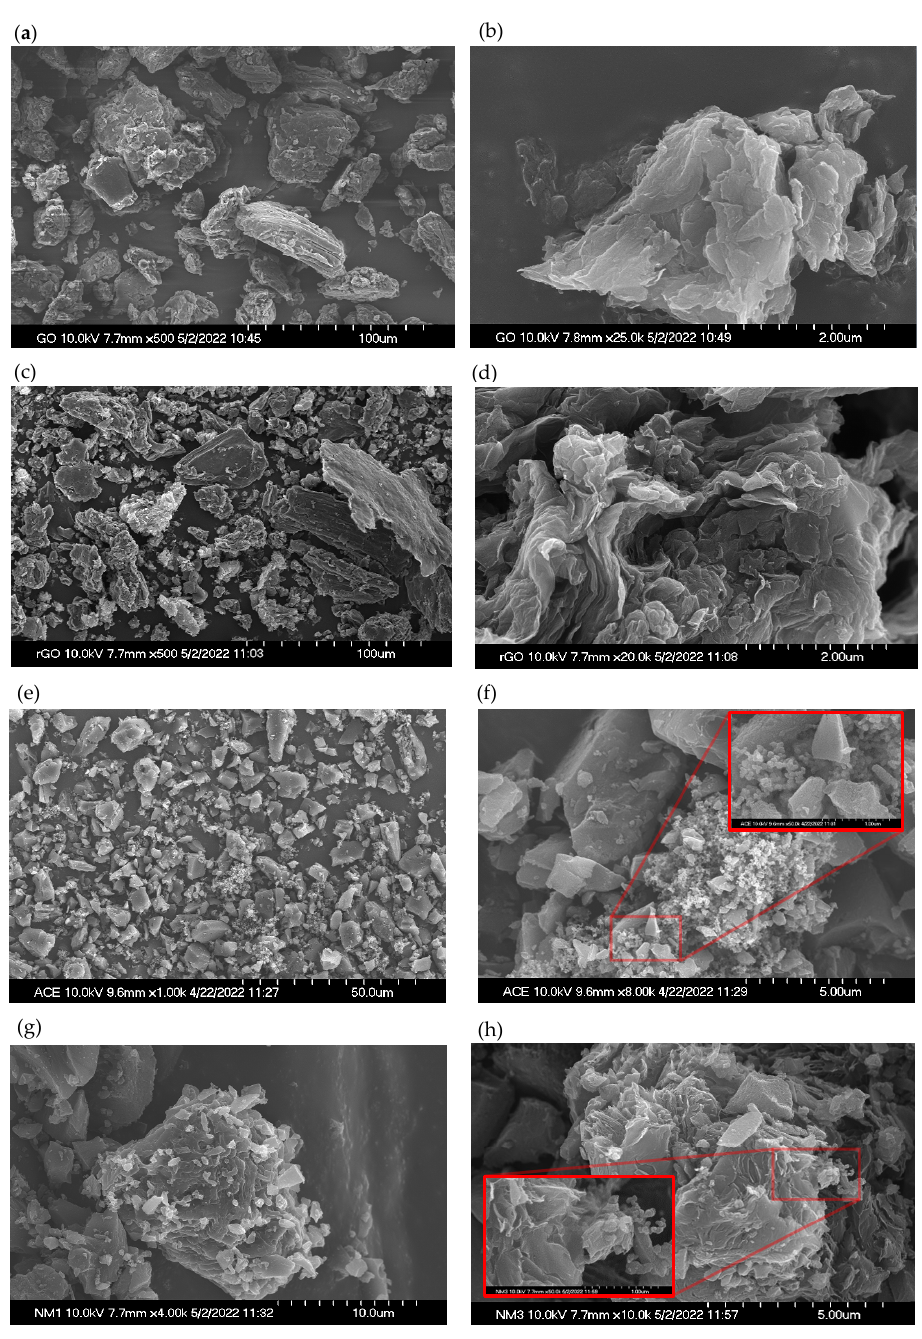
Figure 3. FESEM images of electrode components and their combinations: low ( a ) and high ( b ) mag- nifications of GO; low ( c ) and high ( d ) magnifications of rGO; low ( e ), high ( f ), and highest (inset) magnifications of ACE; high ( g ) magnification of GO particle in M1 mixture; high ( h ) and highest (inset) magnifications of rGO in M3 mixture.